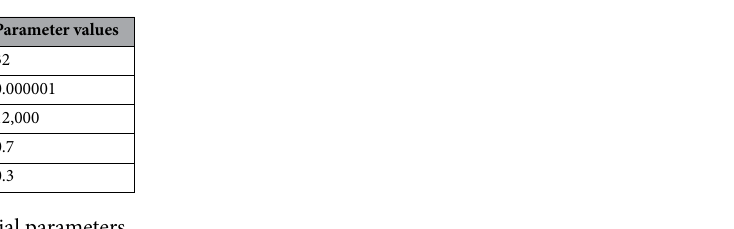
Table 4. Faster R-CNN partial